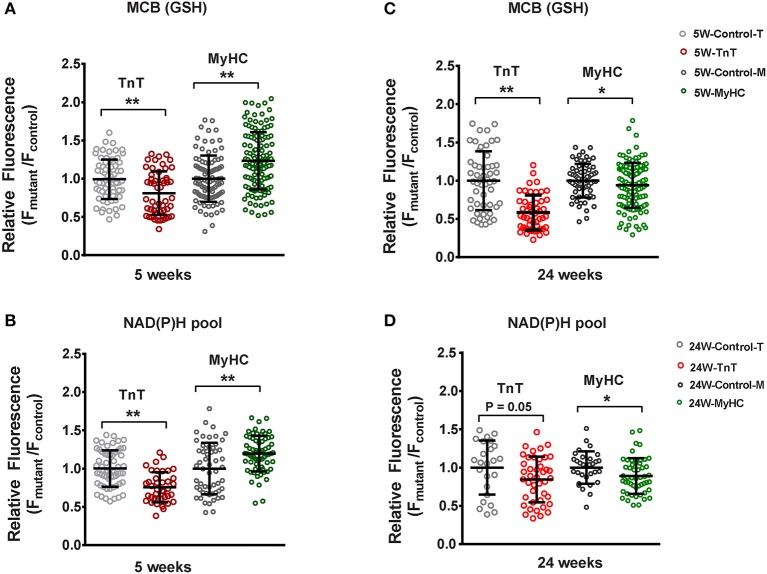
Two photon microscopy to assess redox status in mouse cardiac myocytes at 5 and 24 weeks of age. Cardiac myocytes were labeled with monochlorobimane (MCB; 50 μM, blue λem 480 ± 20 nm) at 37°C, to monitor reduced glutathione (GSH). Data from mutant myocytes is presented as fluorescence units normalized to littermate control myocyte data. NAD(P)H was assessed in non-labeled cells by measuring autofluorescence (total fluorescence collected at <490 nm). Potassium cyanide (KCN; 1 mM) and carbonyl cyanide-4-(trifluoromethoxy) phenylhydrazone (FCCP, 5 μM) were used to calibrate the NAD(P)H signal, permitting estimation of the NAD(P)H pool. All fluorescence recordings were obtained from non-paced cardiac myocytes. (A) TnT mutant myocytes had lower GSH (MCB signal), and MyHC mutant myocytes had higher GSH when compared to respective littermate control myocytes at 5 weeks of age. (B) NAD(P)H pool was lower in TnT mutant myocytes, and higher in MyHC mutant myocytes, when compared to respective littermate control myocytes at 5 weeks of age. (C) At 24 weeks of age, GSH (MCB signal) was lower in both mutant myocytes when compared to respective littermate control myocytes. (D) At 24 weeks of age, only MyHC mutant myocytes had statistically lower NAD(P)H pool levels, when compared to littermate control myocytes; a trend toward lower NAD(P)H pool levels were seen in TnT mutant myocytes when compared to littermate control myocytes (p = 0.05) (control-T, TnT-littermate control; TnT, TnT-mutant; Control-M, MyHC-littermate control; MyHC, MyHC-mutant) [Data are expressed as mean ± S.D. We present results from three mouse hearts (~20–40 myocytes per animal) in each mutant and control group. The two-tailed unpaired Student's t-test was used to compare TnT mutant myocytes and MyHC mutant myoytes with respective littermate control myocytes; *P < 0.05; **P < 0.01].